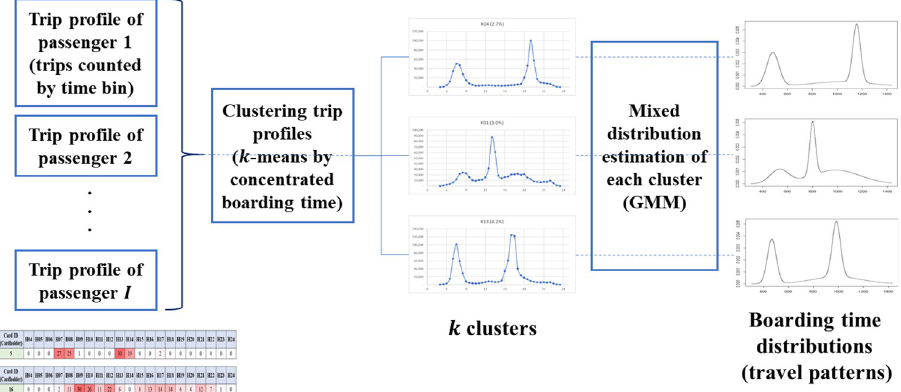
Fig 3. Concept of travel pattern extraction. Note: Travel patterns are extracted by clustering each passenger’s trip profile and estimating mixed distributions (GMM) of the clustered profiles.